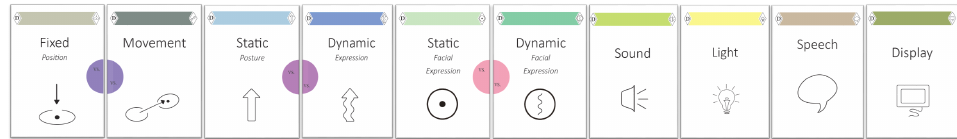
Figure 1. Categories of the Modality Card Deck representing different modalities a robot can use to